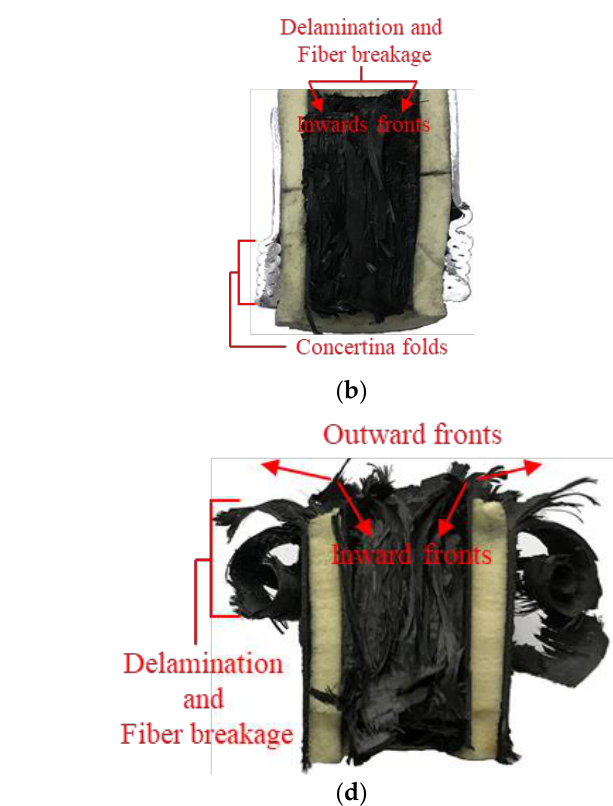
Figure 7. Internal deformation mode of hybrid structures: ( a ) AL-PU-AL; ( b ) AL-PU-C; ( c ) C-PU-AL; ( d ) C-PU-C.